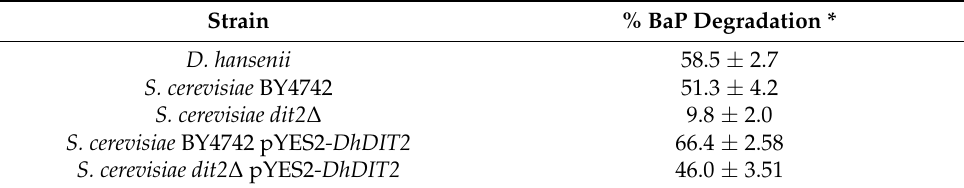
Table 3. Percentage of BaP degradation by different yeasts after 24